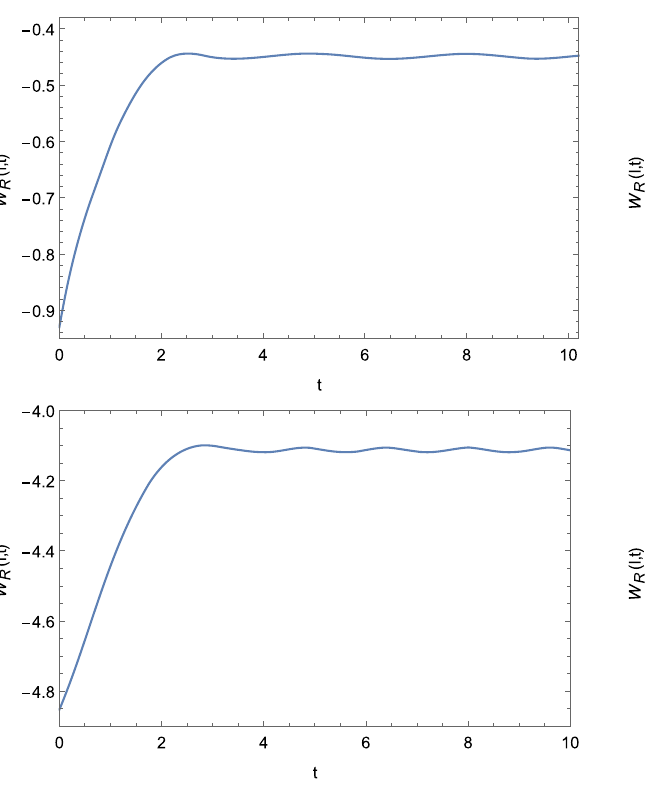
Fig. 3 The expectation value of the Wilson loop in terms of boundary time for ν = 1 (top-left), ν = 2 (top-right), ν = 3 (bottom-left) and ν = 4 (bottom-right). For all figures we set k = 3, T